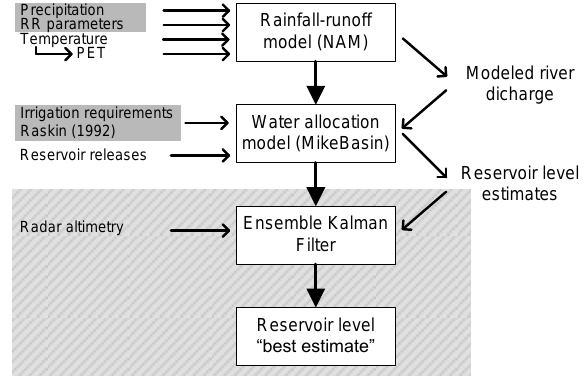
Fig. 2. Block diagram of the modeling and assimilation approach, showing input data (left side), processing (center) and output data (right side). The input data in dark shading have been perturbed to create the ensembles. The processes on slanted shading only occur when there is altimetry data available.